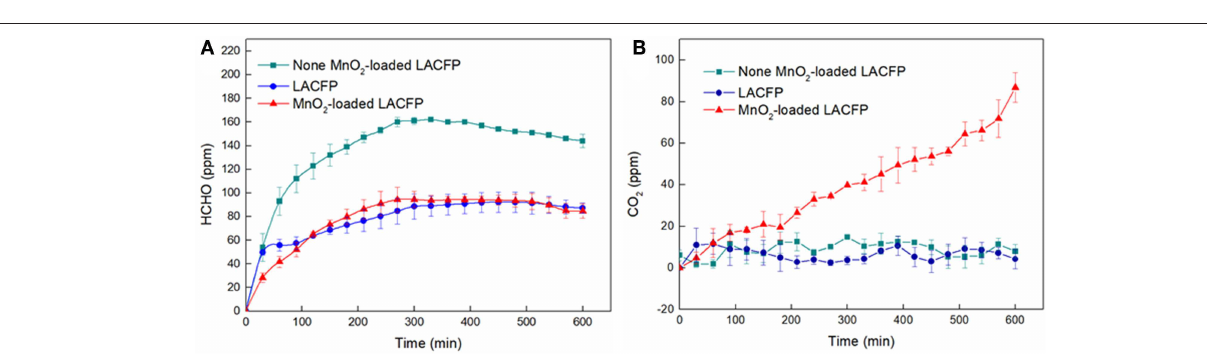
FIGURE 8 | The morphology of LACFP by HRTEM (B) and the morphology of MnO 2 -loaded LACFP by SEM (A) , TEM (C) , and HRTEM (D) .